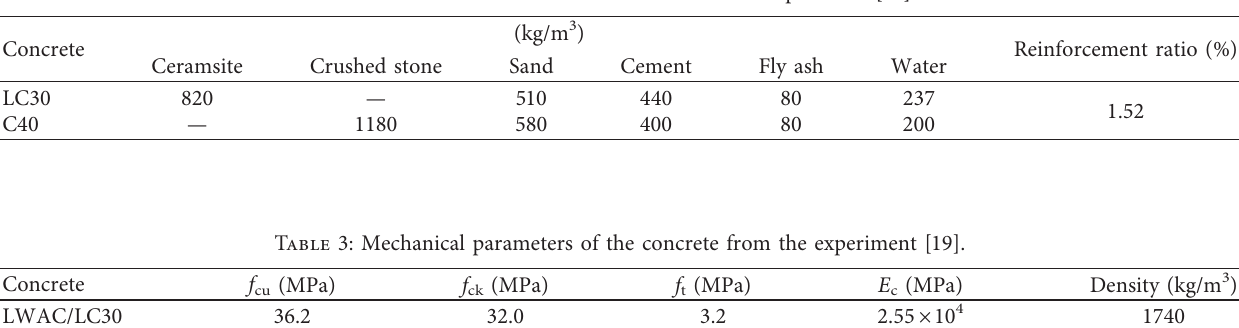
Table 2: Mix ratio of LWAC and NWC of the experiment [19].